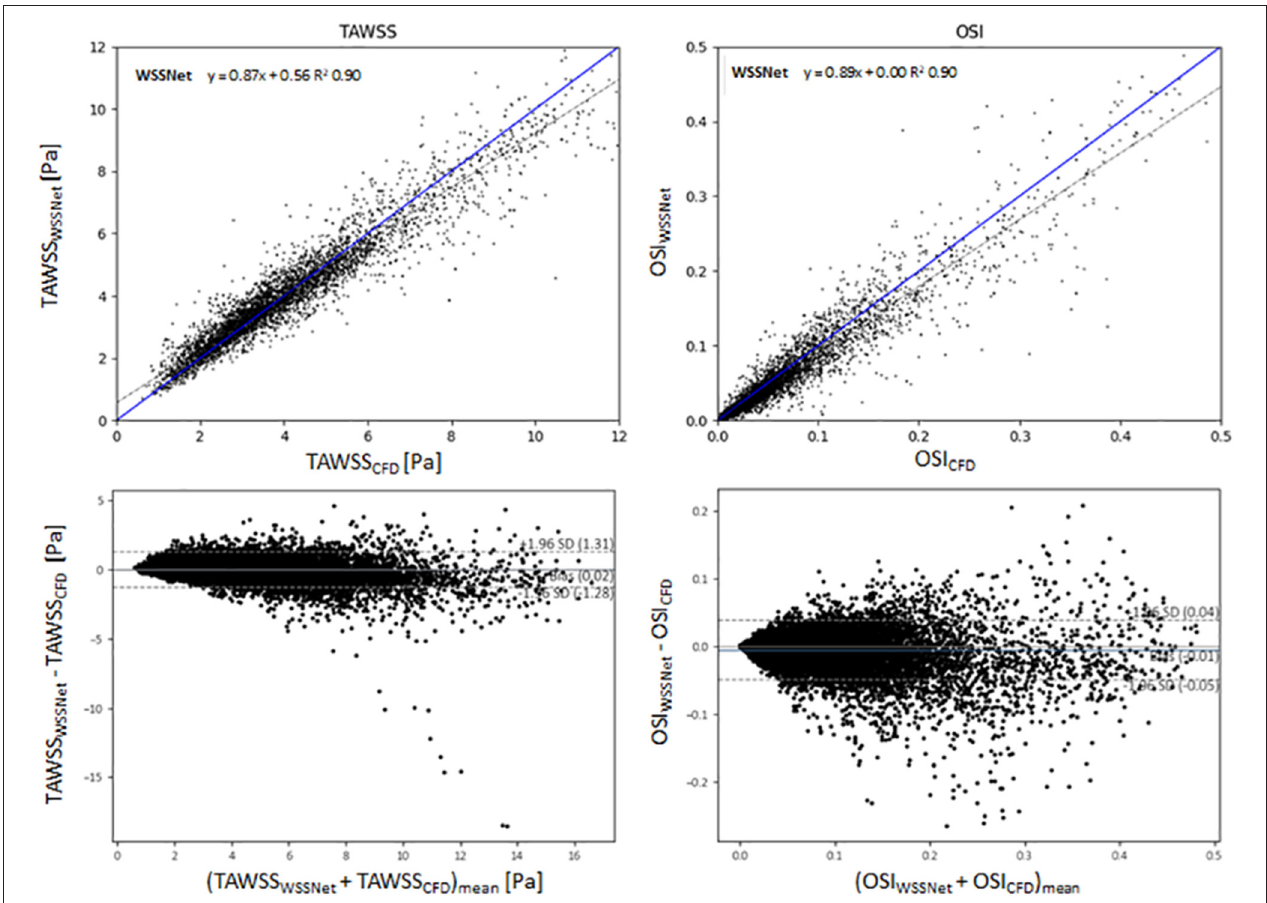
FIGURE 8 | Top: Regression plot for TAWSS and OSI between estimated values from WSSNet and ground truth CFD. TAWSS and OSI have computed over 6 cases (3 validation and 3 test) averaged over 72 time frames (dt = 10ms). Bottom: Bland-Altman plots for TAWSS and OSI. The plots show a point-wise comparison within the flatmap. The plots show 20% of the data points, randomly